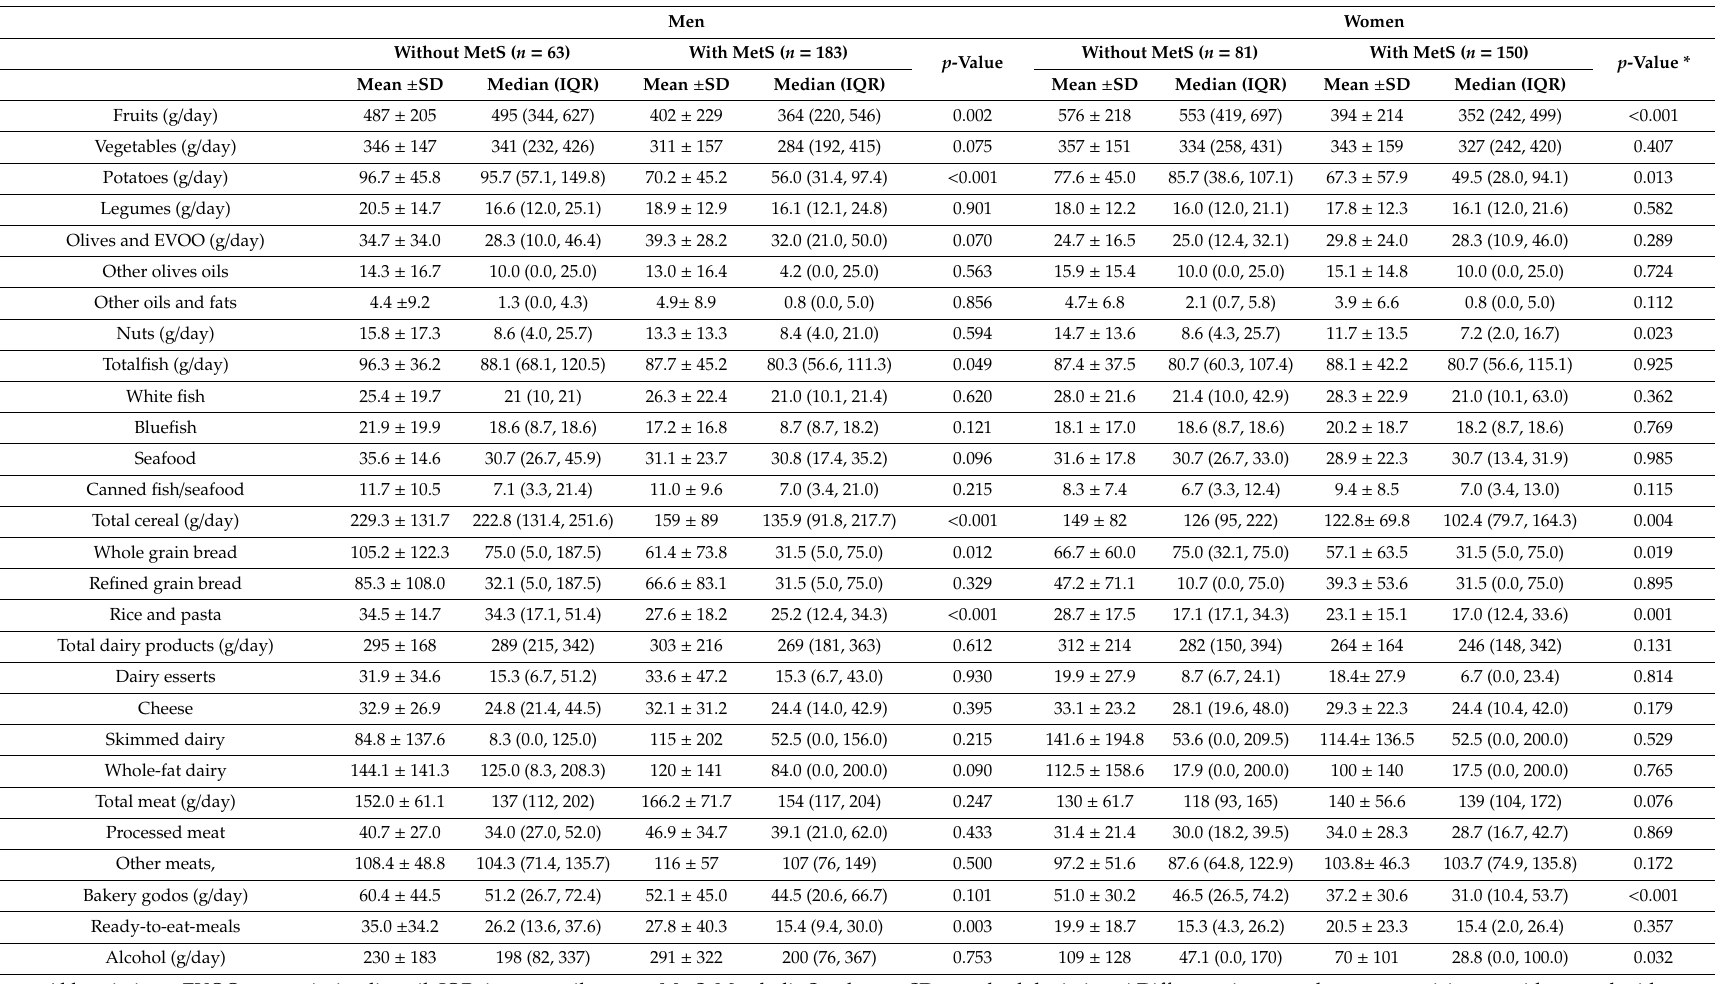
Table 3. Food consumption in participants “with Metabolic Syndrome” ( n = 333) and “without Metabolic Syndrome” ( n = 144) stratified by